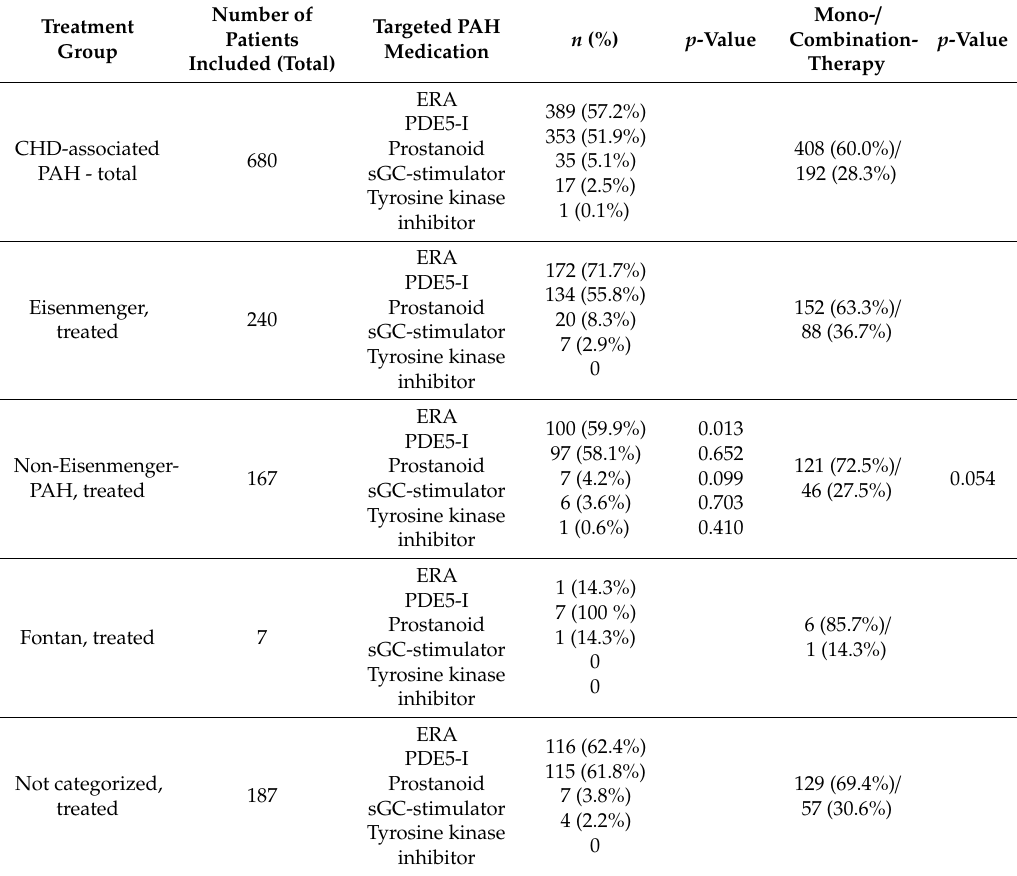
Table 3. Targeted PAH treatment of the patients with congenital heart disease-associated pulmonary arterial hypertension. “Non-Eisenmenger-PAH treated” comprises patients with congenital heart disease-associated pulmonary arterial hypertension but without Eisenmenger syndrome who received targeted PAH treatment. Abbreviations: ERA, endothelin receptor antagonists; PAH, pulmonary arterial hypertension; PDE5-I, phosphodiesterase type-5 inhibitors; sGC-stimulator, soluble guanylate cyclase (sGC) stimulator. Comparative tests were only performed between treated Eisenmenger and non-Eisenmenger